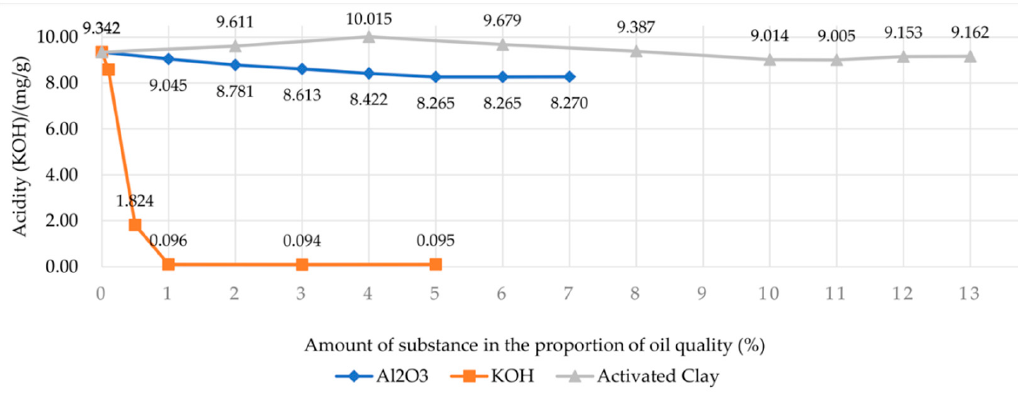
Figure 2. E ff ects of three di ff erent treatments on the acidity value of Jatropha curcas seed Figure 2. Effects of three different treatments on the acidity value of Jatropha curcas seed oil.